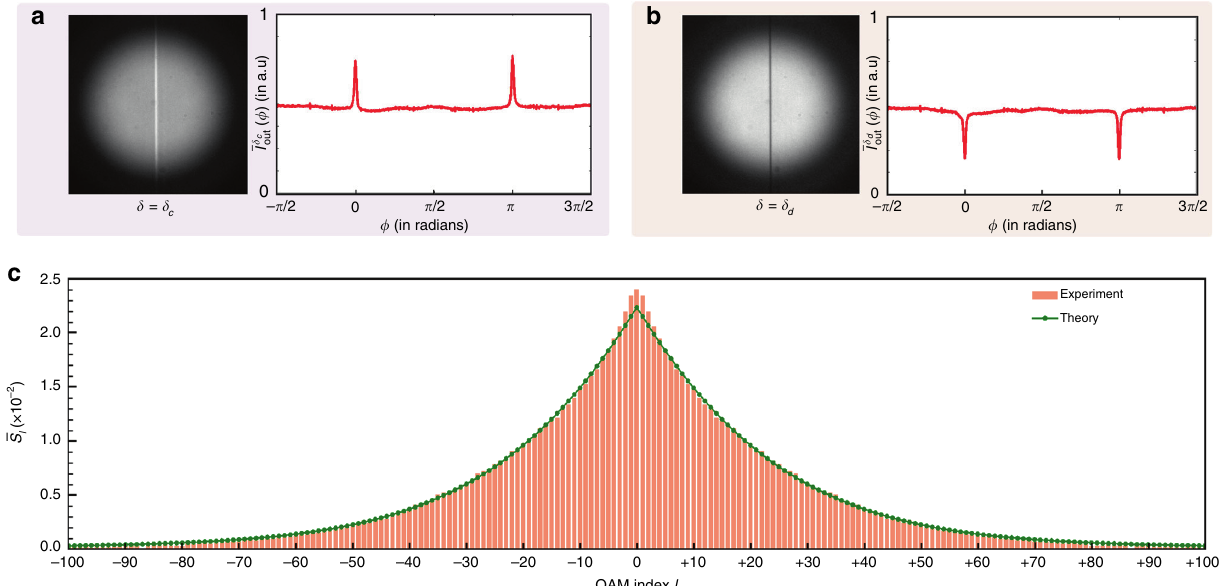
Fig. 3 Experimental results obtained with fi elds produced by parametric down-conversion. a , b Measured output interferogram and the azimuthal intensity for δ = δ c and δ = δ d , respectively. c The normalized measured spectrum S l as computed using Eq. (8), and the normalized theoretical spectrum as calculated using the formalism of ref. 42 , for our setup parameters, namely, a type-I collinear down-conversion with a 2-mm thick BBO crystal and a 0.85- mm beam-waist pump laser. The theoretical spectrum has no fi tting parameters. The angular Schmidt number K ¼ 1 = is evaluated to be